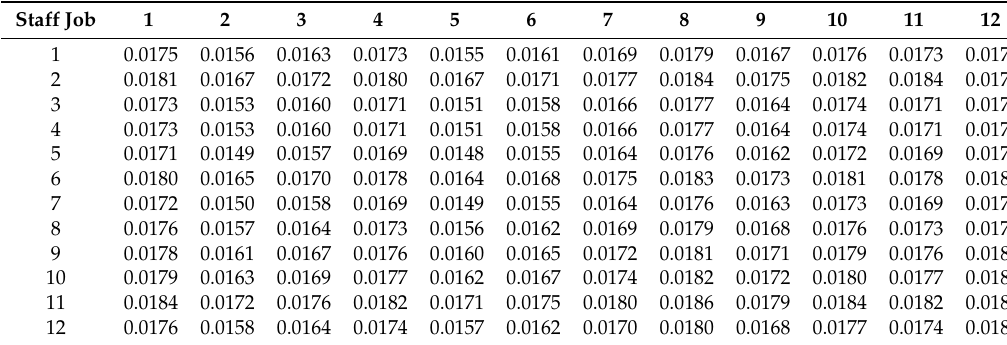
Table 13. Human waste rate